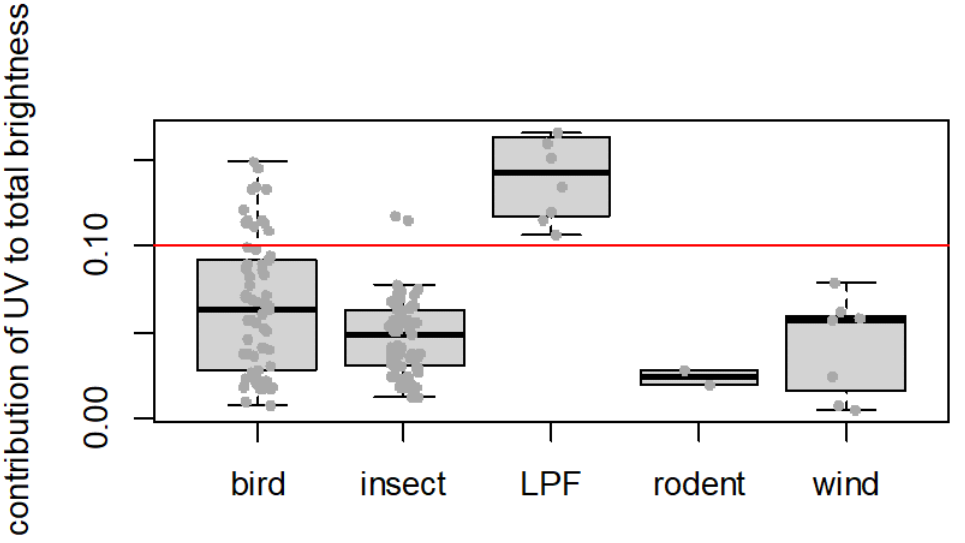
Figure 1. Contribution of UV reflectance (300-400 nm) to total brightness for Erica species in relation to their pollination syndrome (centre line, median; box limits, upper and lower quartiles; whiskers, 1.5x interquartile range), red line indicating UV reflectance for samples above 0.1. Number of species: bird = 61, insect = 69, LPF = 8, rodent = 2, wind =